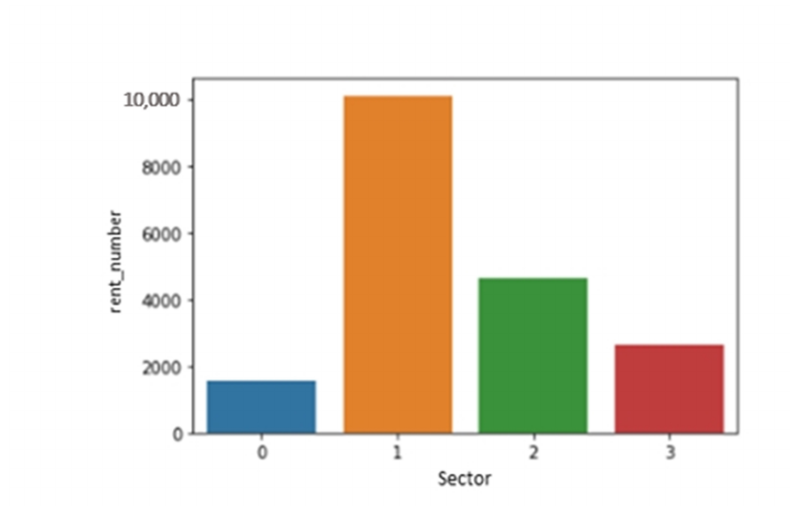
Figure 4. Sector wise rent demand graph.